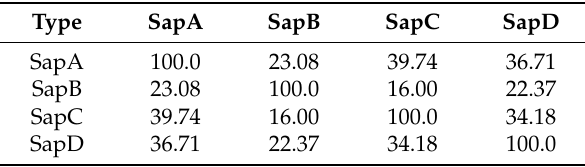
Table 2. Percent identity matrix for multiple sequence alignment of human saposins 1 .